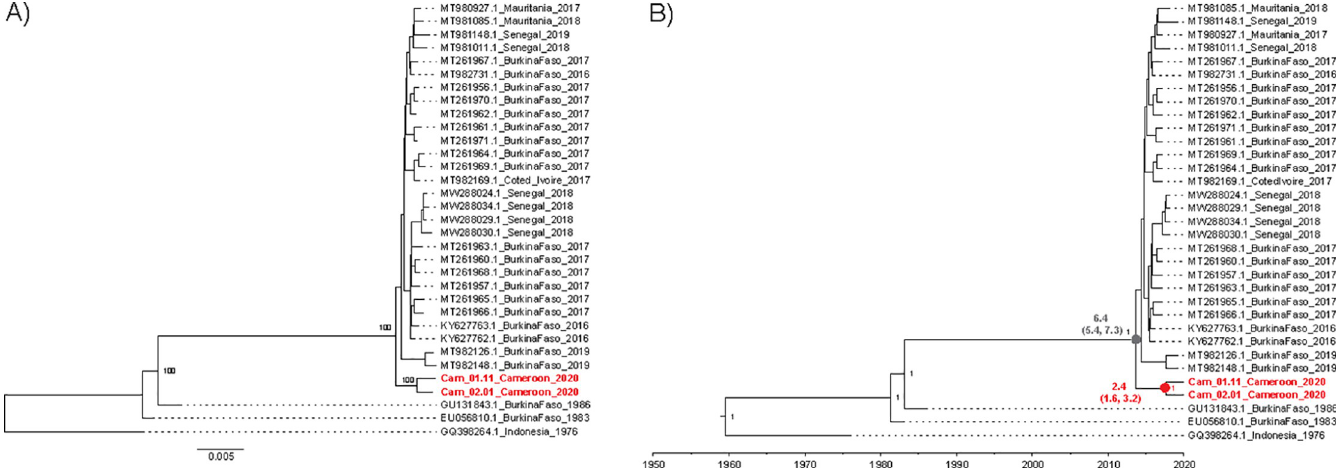
Fig 1. Phylogenetic analysis of DENV2 Cosmopolitan genotype sequences from West Africa. A) Maximum likelihood tree. Scale bar indicates genetic distance. Nodes in the ancestral lineage of Cameroon sequences are labeled with percent bootstrap support. B) Time-scaled maximum clade credibility tree. Nodes are labeled with posterior probability for the most recent common ancestor of Cameroon sequences (red) and its most proximal ancestor with other West African sequences (gray). Text boxes indicate the median node age and 95% HPD in years prior to 2020.